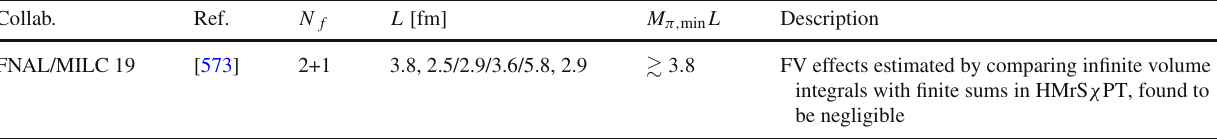
Table 157 Finite-volume effects in determinations of B → π(cid:6)ν , B s → K (cid:6)ν , and (cid:8) b → p (cid:6) ¯ ν form factors. Each L -entry corresponds to a different lattice spacing, with multiple spatial volumes at some lattice spacings. For actions with multiple species of pions, the lightest masses are quoted Collab.